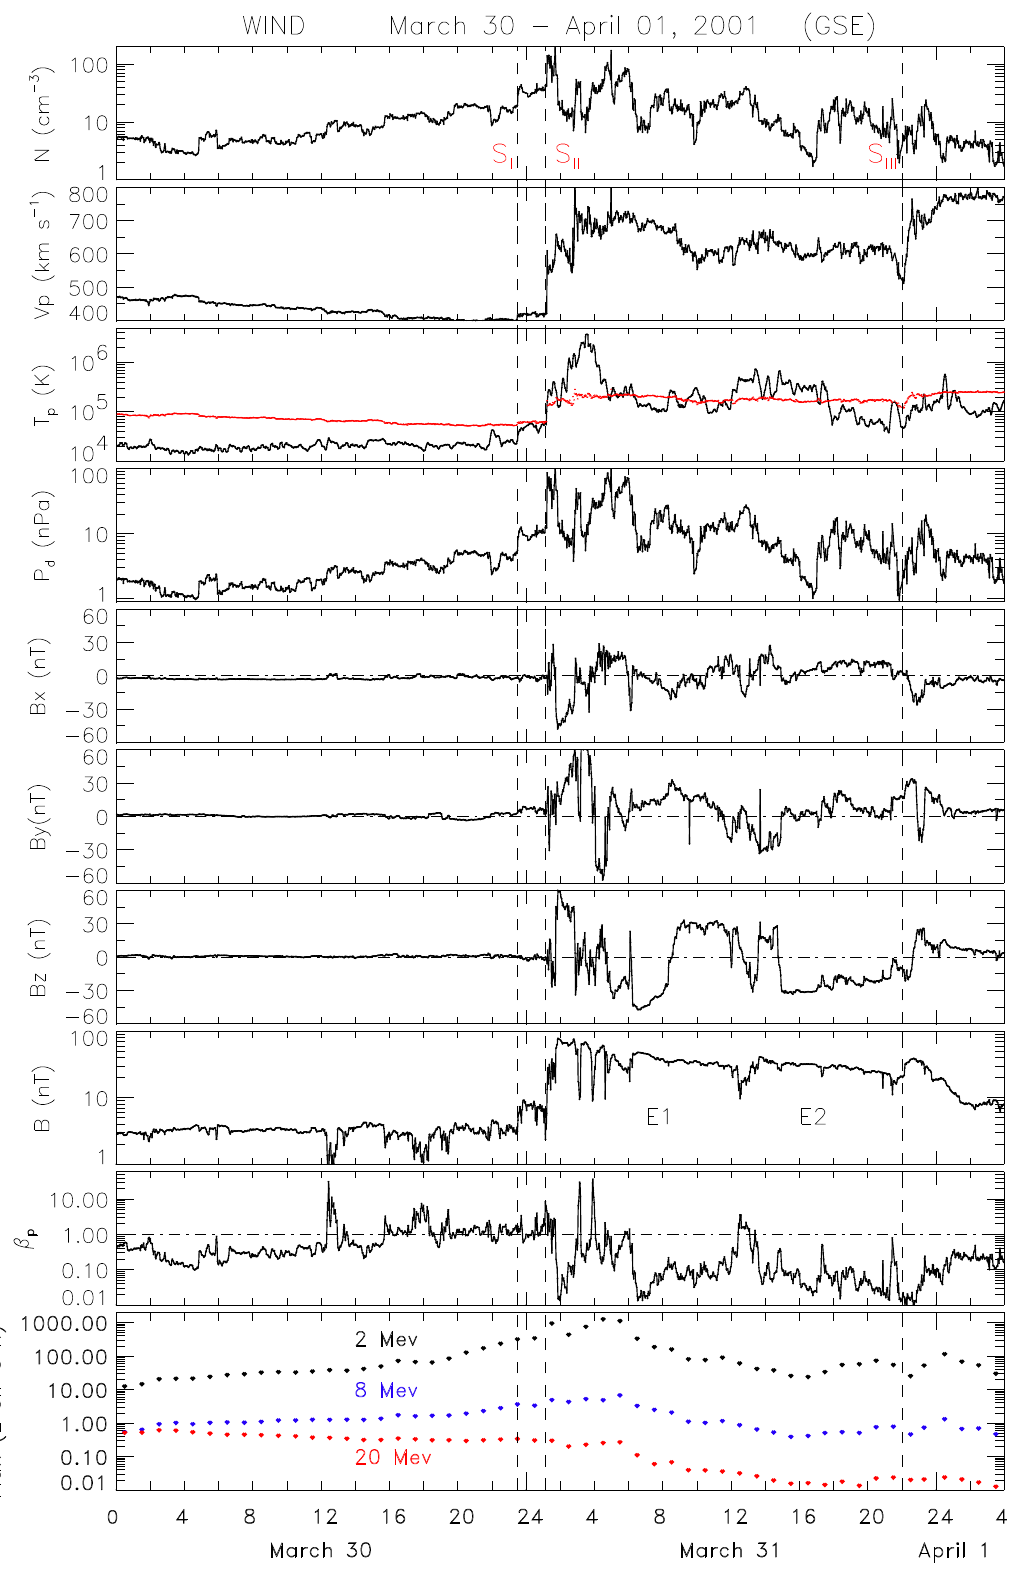
Fig. 7. A blow-up of the period 30 March − 04:00 UT, 1 April showing proton plasma, magnetic field and energetic particle data. The figure highlights the differences in plasma and field parameters measured on 30 March and 31 March ,